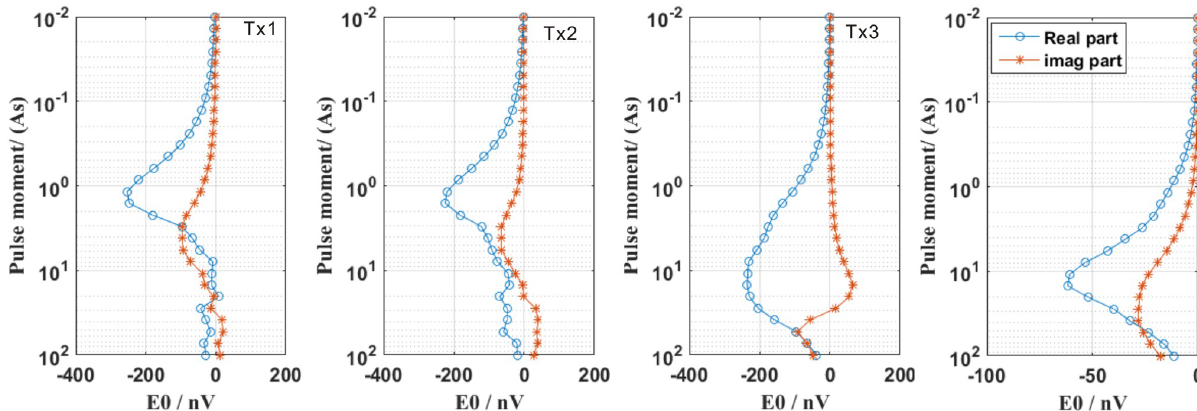
Fig 20. Synthetic FID sounding curves for different loop positions (i.e., Tx1–Tx4).